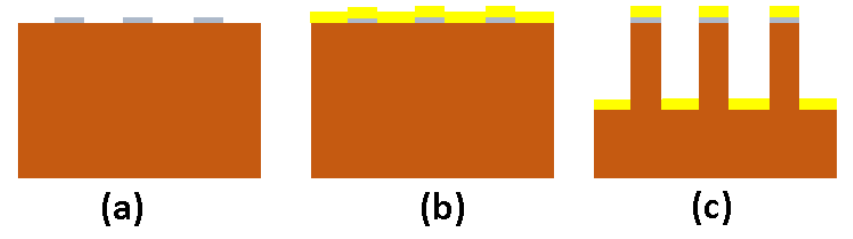
Figure A1. Grating structure fabrication process using MACE method.